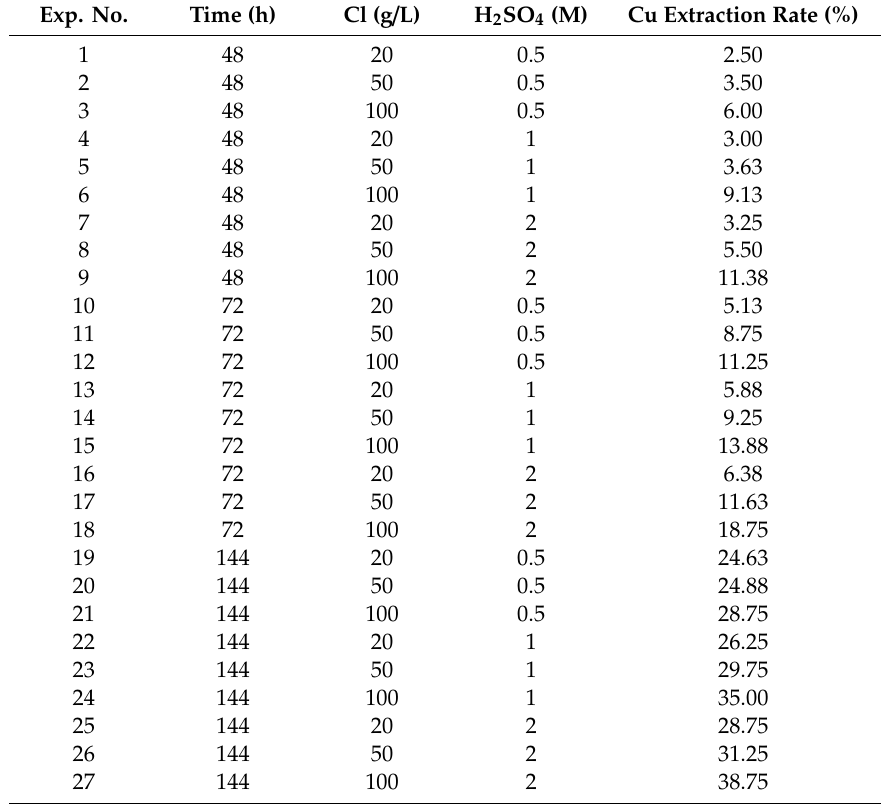
Table 4. Experimental configuration and Cu extraction data (at T = 25 ◦ C, Stirring rate = 600 rpm, P = 1 atm). Exp. No.